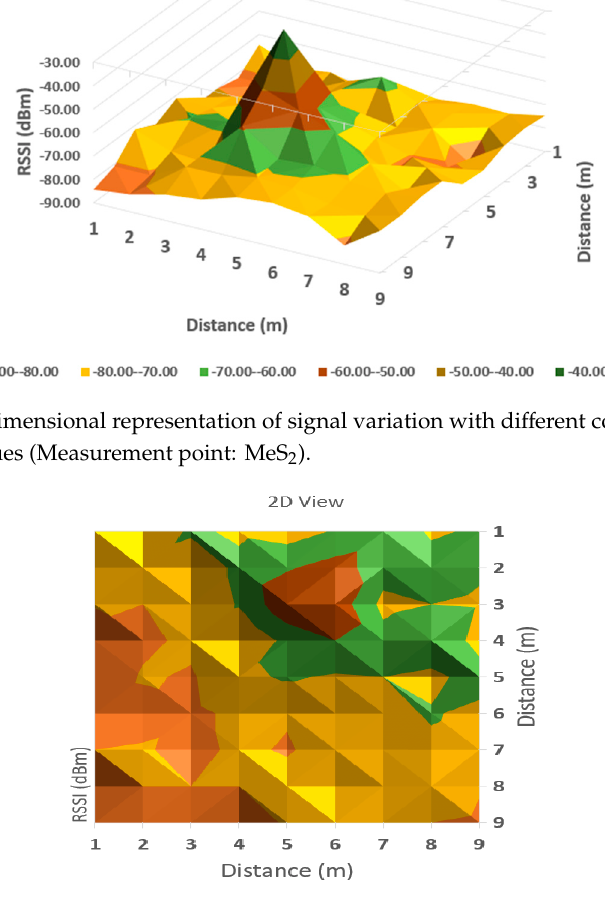
Figure 10. A two-dimensional representation of signal variation with different coloring according to RSSI measured values (Measurement point: MeS 3 ). Sensors 2020 , 20 , 7327 12 of 26